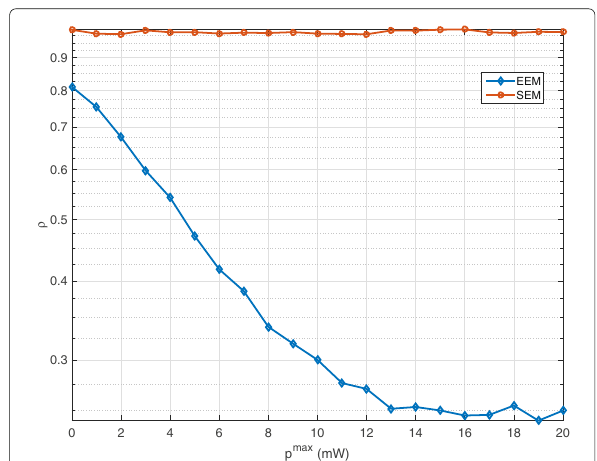
Figure 6 indicates the power utilization ratio compar- ison with detection probability. It can be seen that, as Q d grows, the power utilization ratio of SEM is always 100%. SEM only focuses on maximizing spectrum effi- ciency and ignores the power consumption. Thus, it tends to use the entire power to maximize the spectrum effi- ciency during the optimization, leading to the 100% power utilization ratio. However, in EEM, the power consump- tion gains lots of attention and the power utilization ratio always keeps a low level, which indicates that detec- tion performance is improved via setting a limit to the power consumption. Figure 7 shows the power utiliza- tion ratio comparison with maximal power. It is seen that EEM can also achieves higher power utilization compared with